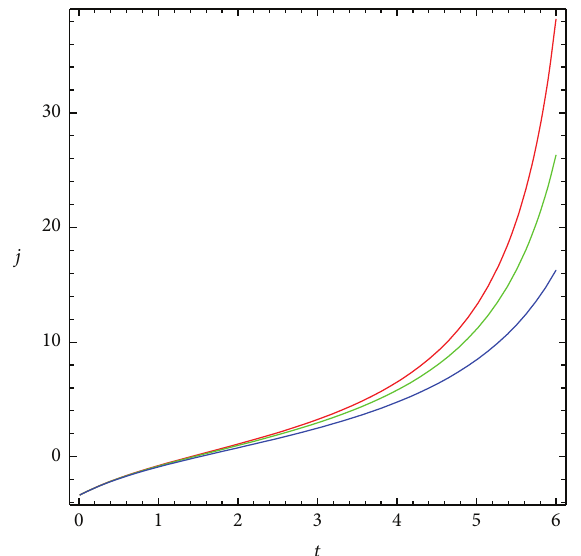
Figure 19: Jerk parameter plot corresponding to (44).